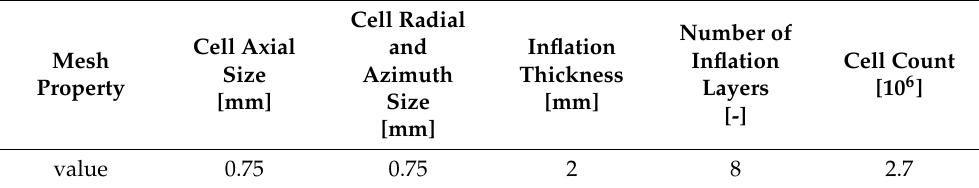
Figure 9. Relative standard deviations of axial and tangential velocities at six points along the air gap in the cases of the basic and doubled domains. The definition of an adequate domain span is considered next. For this, the 𝜆 − 2 iso- surfaces in the two domains were compared. Their plots are shown in Figure 10. Clearly, their vortex structures are very similar. However, there is a presence of slightly wavy Tay- lor vortex pairs in the second half of the wider domain. This agrees with the differences in the reported relative standard deviations shown in Figure 9, which indicate considera- bly different variability in the flow in the wider domain. The larger domain span thus seems to allow for an additional degree of freedom, and affects the development of flow structures. Figure 10. Iso-surfaces with a 𝜆 − 2 value of −0.2 1/s 2 in simulations with the initial and doubled domain spans.